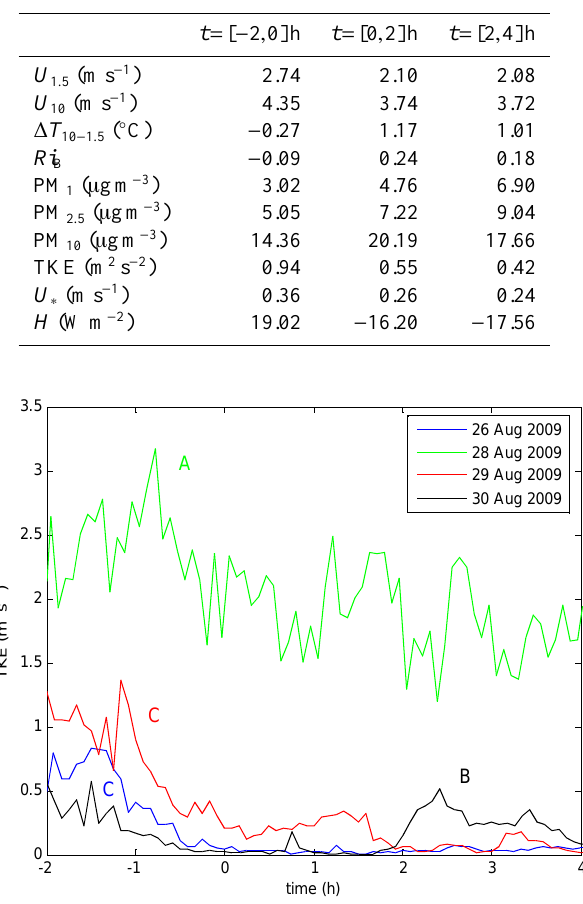
Table 1. Mean values of wind speed, temperature di ff erence be- tween 10 and 1.5m, the Bulk Richardson number, particle concen- trations and turbulent parameters for the time ranges used at the CIBA site (July–August 2009). The sunset time is the reference: t sunset = 0h.